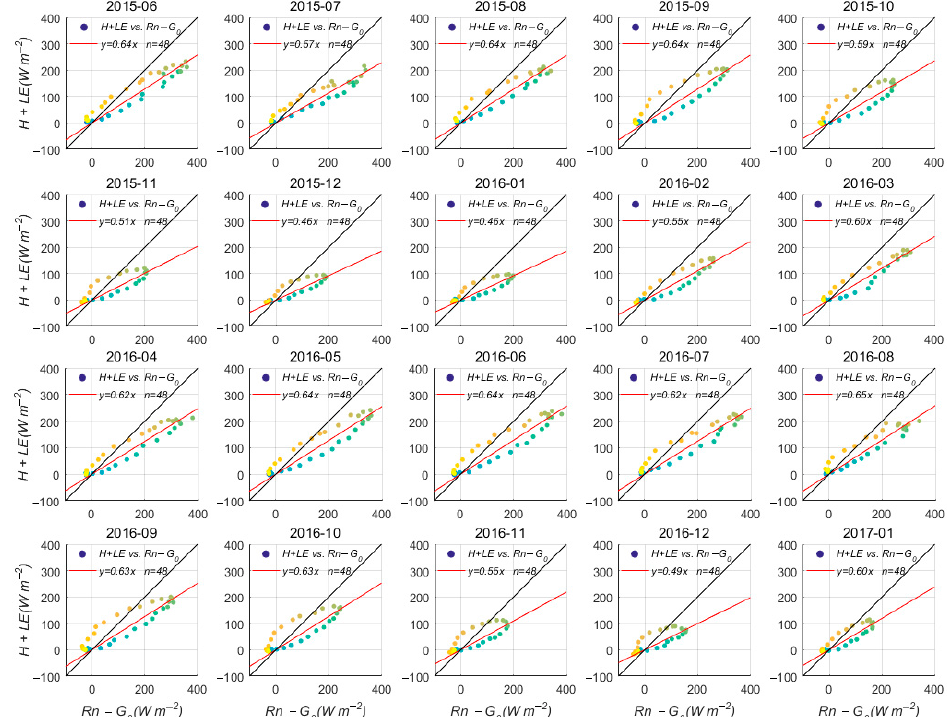
Figure 8. Monthly averaged diurnal variations of turbulent heat fluxes ( H + LE ) versus surface available energy ( Rn – G 0 ) for each of the months in the observation period. Yellow and green dots indicate daytime (10:00–19:00 local time) and nighttime (19:00–10:00 local time), respectively.